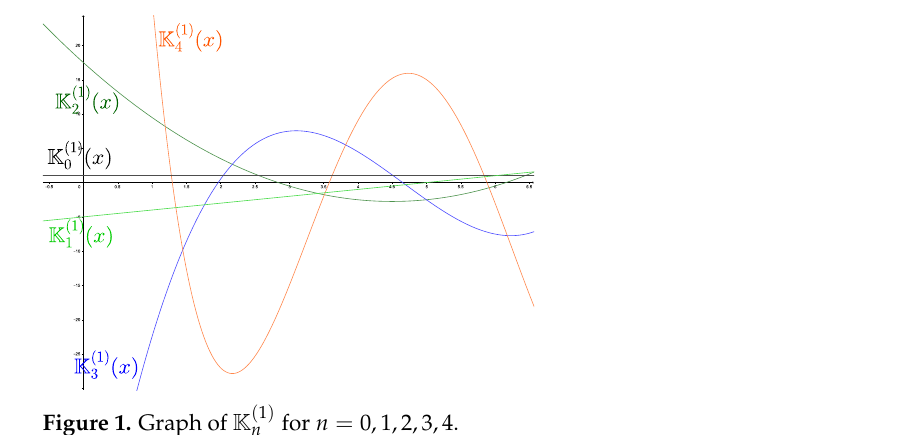
Figure 1. Graph of K